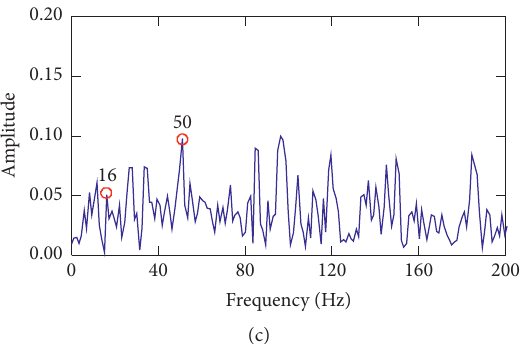
Figure 16: Analysis results of simulation signals by the SK method: (a) fast kurtogram; (b) envelope signal; (c) envelope spectrum.